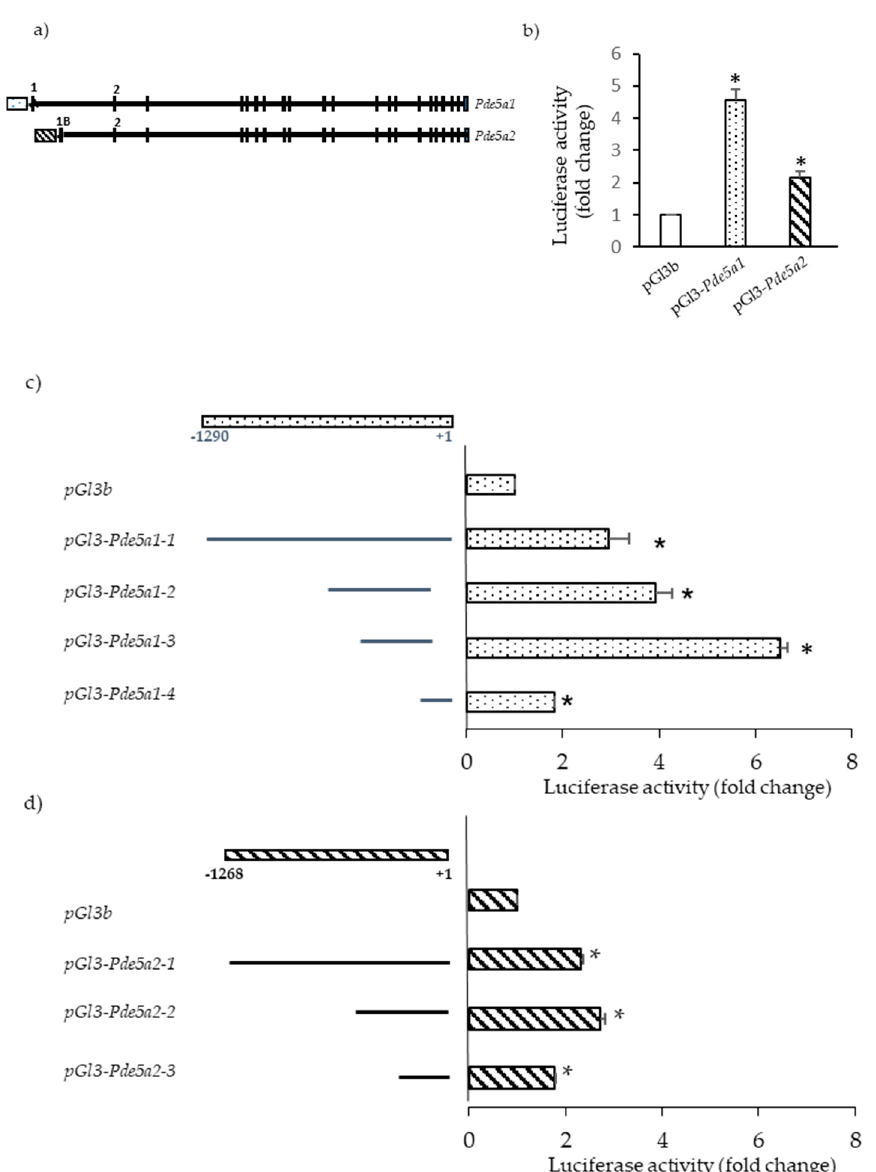
Figure 3. Analysis of Pde5a1 and Pde5a2 promoter activity. ( a ) Scheme of Pde5a gene organization; dotted and striped boxes represent the putative promoter regions. ( b ) NIH-3T3 cells were transiently transfected with each of the plasmids containing the firefly luciferase reporter under the control of Pde5a1 and Pde5a2 promoter ( b ) or several fragments of these promoters ( c , d ). Results are expressed as the fold change activity relative to that observed with the pGl3 basic empty plasmid. Values represent the mean ± SD of at least n = 4 different experiments performed in triplicate. * Indicates statistical significance of promoter constructs with respect to empty vector ( t -test: p < 0.05).